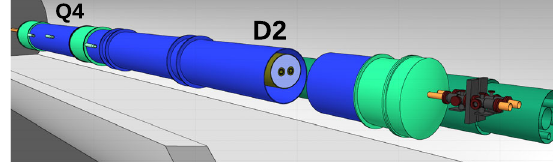
FIG. 6. Geometry model of the cryogenic unit downstream of the wire scanner, containing the D2 dipole and the Q4 quadru- pole. The cryostat and the dipole are cut open to show the interior.